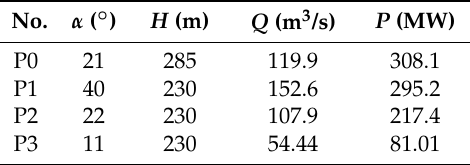
Table 2. Studied operating